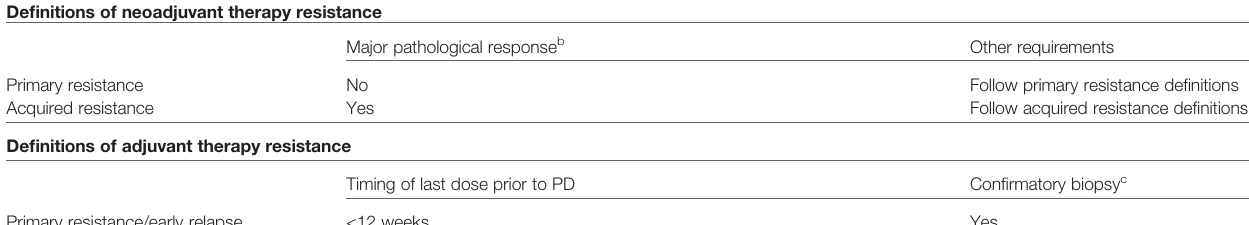
TABLE 1 | The de fi nitions for PD-(L)1 inhibitor monotherapy resistance in solid tumors a . De fi nitions of neoadjuvant therapy